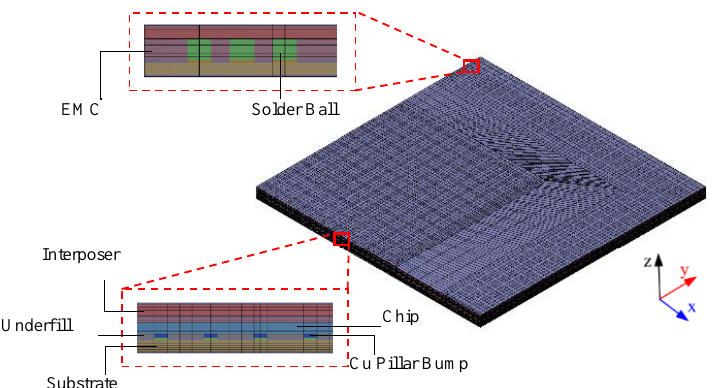
Figure 6. 3D FE model of the FCPoP assembly.